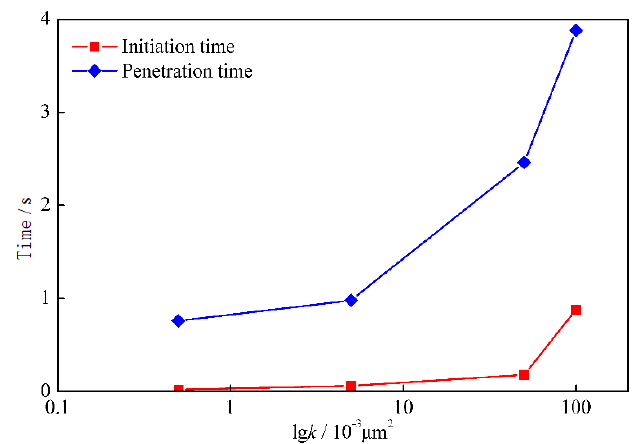
Figure 6. Initiation and penetration times of hydraulic fractures under different permeabilities.